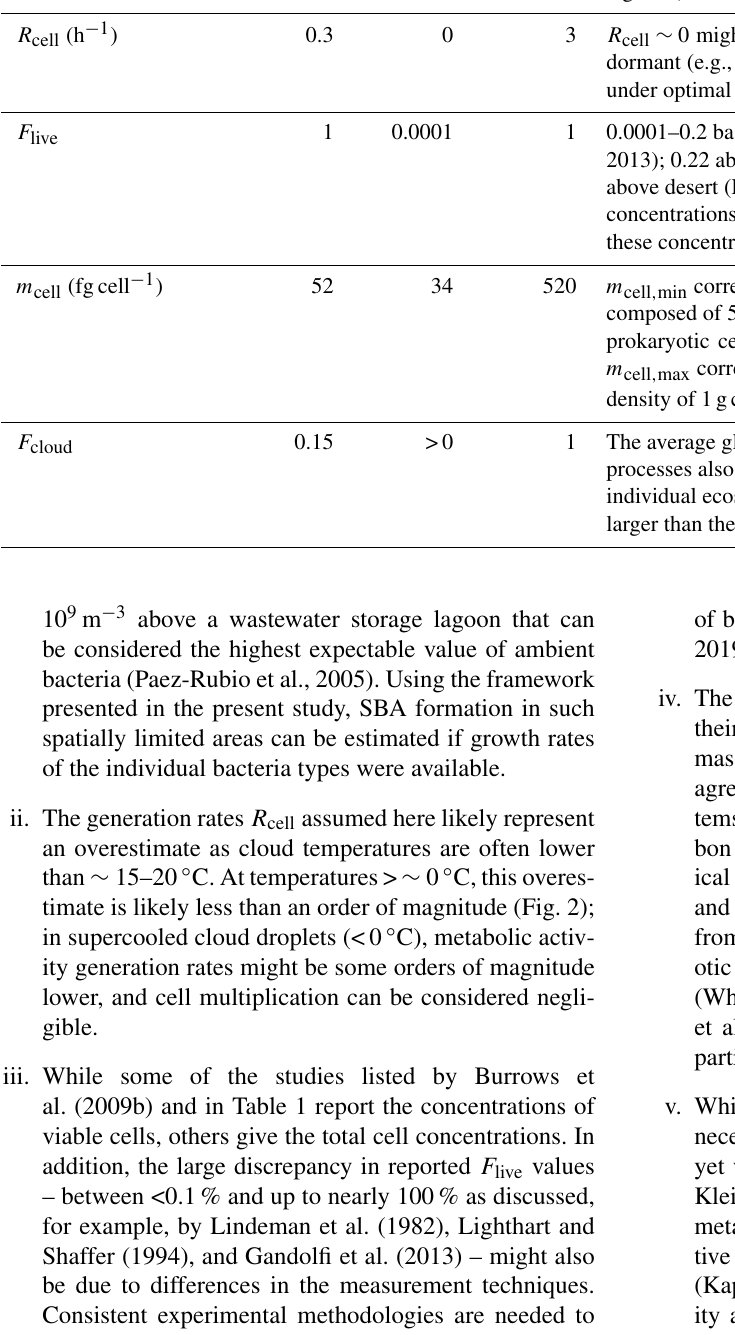
Table 3. Parameters used in the estimate of SBA mass formation and their possible minimum and maximum values based on literature data. Range Parameter Value in Minimum Maximum Comment Eqs. (4) and (5) C cell (m − 3 ) 10 4 100 10 9 C cell , min : above desert during low RH and high radiation (Lighthart and Shaffer, 1994); ∼ 10 6 : in a highly polluted area (Xi’an, China) (Xie et al., 2018); C cell , max was measured above a wastewater storage lagoon (Paez-Rubio et al., 2005). R cell (h − 1 ) 0.3 0 3 R cell ∼ 0 might occur under stressful conditions when cells become dormant (e.g., low temperature, little water); R cell ∼ 3 for E. coli under optimal conditions (37 ◦ C, appropriate culture medium). 1 0.0001 1 0.0001–0.2 based on global microbial diversity (Gandolfi et al., 2013); 0.22 above crop fields (Lindemann et al., 1982), 0.81 above desert (Lighthart and Shaffer, 1994). Some studies report concentrations of viable cells; in this case, these concentrations imply F live = 1. 52 34 520 m cell , min corresponds to cells in clouds assuming that cells are composed of 50% carbon (Sattler et al., 2001); masses of other prokaryotic cells might be ≤ 200fgcell − 1 (Whitman et al., 1998); m cell , max corresponding to a spherical cell of a diameter of 1µm and density of 1gcm − 3 (Burrows et al., 2009b). F cloud 0.15 >0 1 The average global value might be higher than 0.15 if bacterial processes also occur outside of clouds. On small scales or above individual ecosystems, the value for clouds can be smaller or larger than the average value, depending on cloud